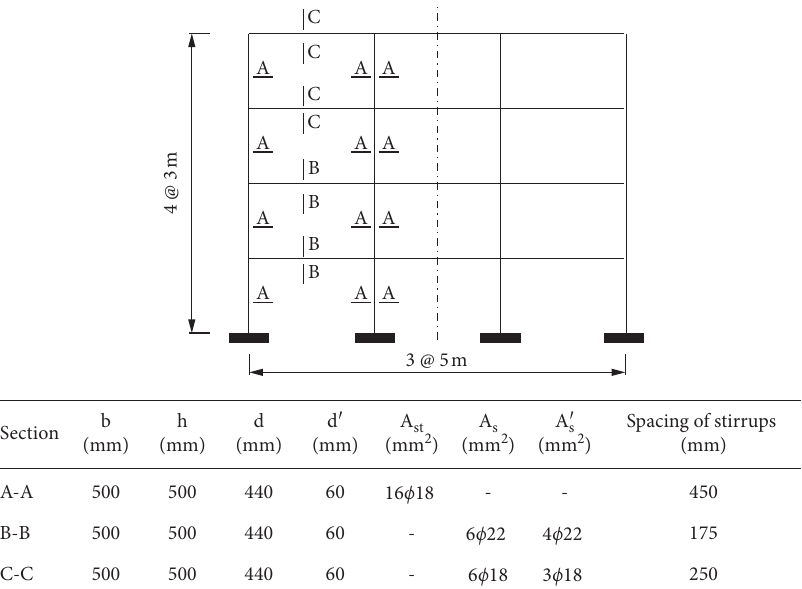
Figure 13: Four-storey frame